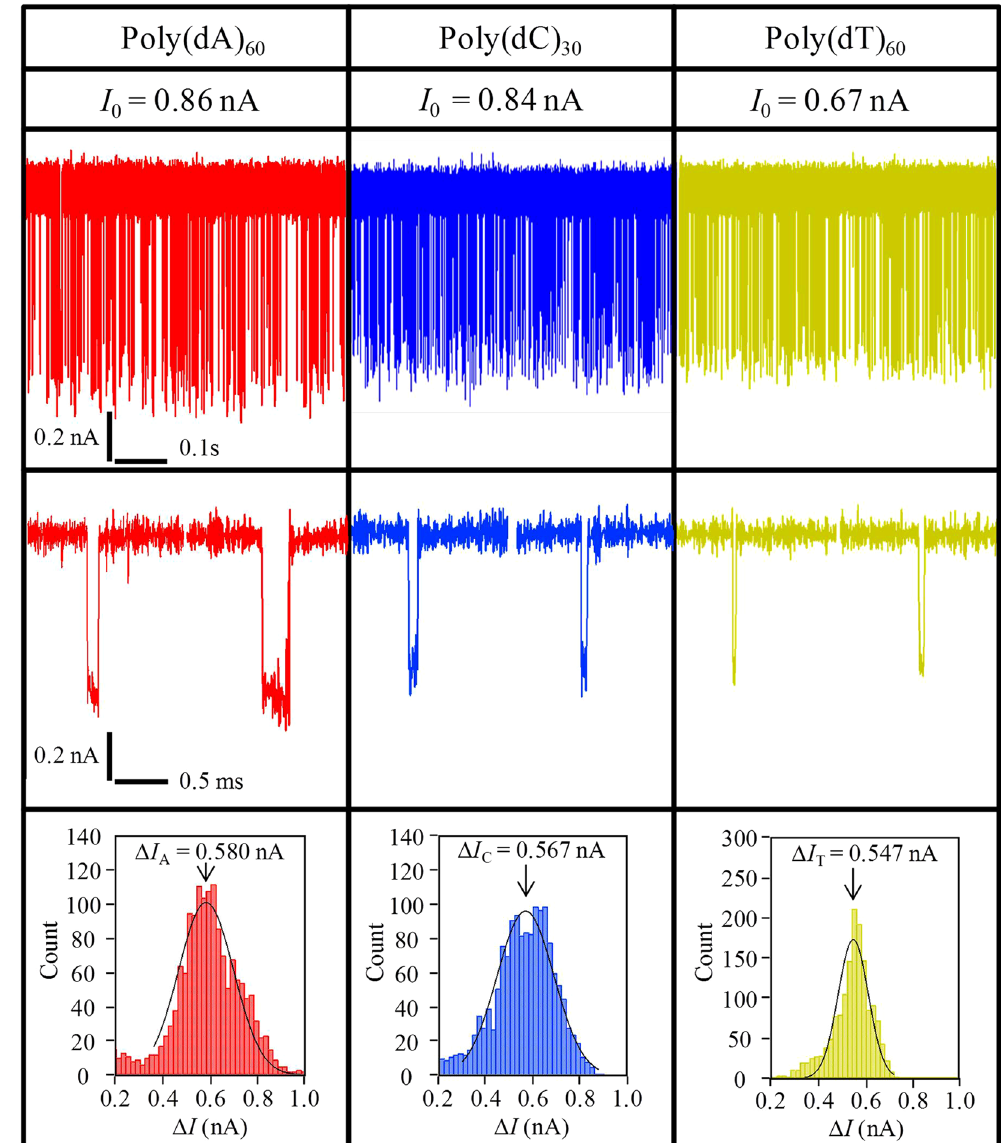
Figure 8. Ionic-current blockades when free poly(dA) 60 , poly(dC) 30 , and poly(dT) 60 passed through a nanopore. Ionic-current blockades ( Δ I ) and their histograms when poly(dA) 60 , poly(dC) 30 , and poly(dT) 60 passed through a nanopore. The aqueous solution in the cis chamber was 1 M KCl with 100 nM poly(dA) 60 , poly(dC) 30 or poly(dT) 60 . The aqueous solution in the trans chamber was 1 M KCl. The applied voltage was 0.1 V. This measurement was performed with the same nanopore. The order of the measurement is (1) poly(dT) 60 , (2) poly(dC) 30 , (3) poly(dA) 60 . The nanopore was washed with pure water between each measurement. The open pore current ( I 0 ) gradually increased with nanopore washing and changing samples, which was difficult to suppress. The peak value of Δ I differed in each